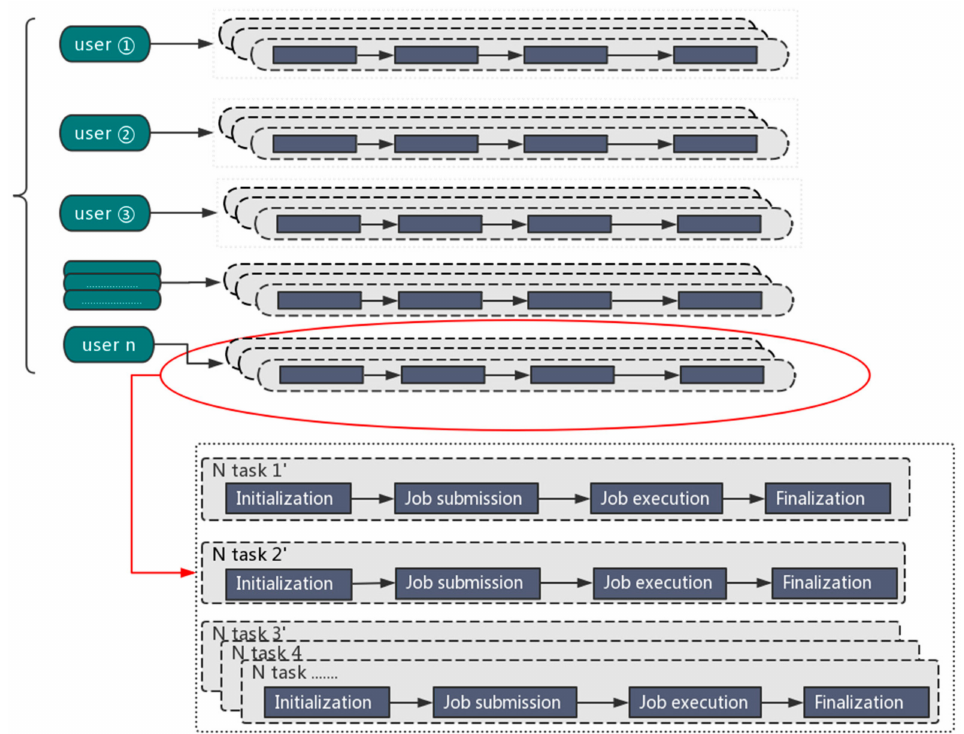
Figure 1. The parallel processing mode for big data